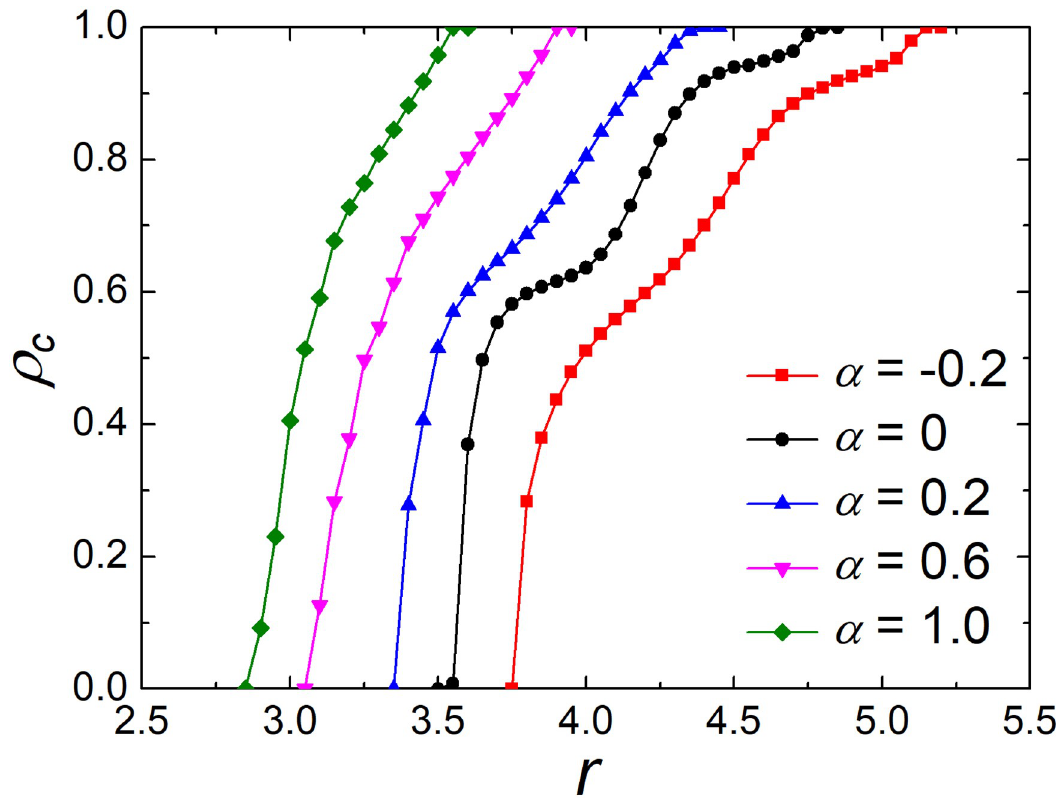
Fig 7. Fraction of cooperators as a function of the investment preference density α on BA scale-free networks. Cooperation can still widely spread at a low level of enhanced factor when this new mechanism is introduced. The depicted results are obtained for M =